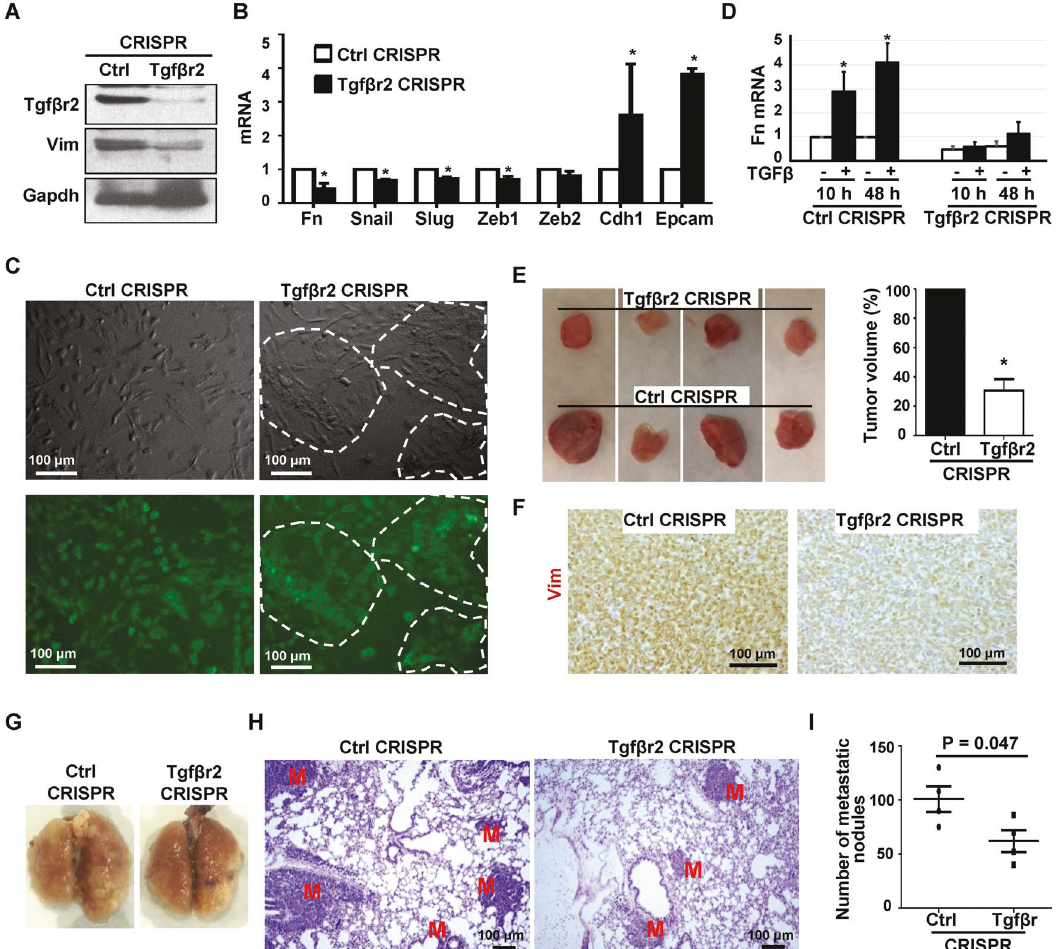
Fig. 5 Deletion of Tgf β r2 in Brca1-de fi cient tumor cells inhibits EMT and suppresses tumorigenesis and metastasis. A – C p18 − / − ; Brca1 MGKO tumor cells were transfected with Tgf β r2 (Tgf β r2 CRISPR) and Control (Ctrl CRISPR) Double Nickase plasmids then selected with puromycin for 3 days. Tgf β r2- and control-knockout cells were then analyzed by western blot ( A ), Q-RT-PCR (B), and microscope for cell morphology ( C ). The areas with epithelial-like cells are indicated in ( C ). D Tgf β r2- and Ctrl-knockout p18 − / − ; Brca1 MGKO mammary tumor cells were treated with vehicle or TGF β for different time periods, and the expression of Fn was then determined. Data in ( B ) and ( D ) represent the mean ± SD from duplicates of two independent experiments. The asterisk (*) in ( B ) denotes a statistical signi fi cance from Tgf β r2- and Ctrl-knockout samples, and in ( D ) denotes a statistical signi fi cance from TGF β treated and vehicle treated samples determined by a two-tailed, paired T test. E , F 6 ×10 5 Tgf β r2- and Ctrl-knockout p18 − / − ; Brca1 MGKO mammary tumor cells were inoculated into the left and right inguinal MFPs of NSG mice, respectively, in a pairwise manner. Two weeks after transplantation, mice were dissected. The volume ( E ) and expression of Vim ( F ) of the regenerated tumors were determined by measurement and IHC. Data in ( E ) represent the mean ± SD of four tumors in each group. The asterisks (*) denote a statistical signi fi cance from Tgf β r2- and Ctrl-knockout tumors determined by a two-tailed, paired T test. G – I 6 ×10 5 Tgf β r2- or Ctrl-knockout p18 − / − ; Brca1 MGKO mammary tumor cells were inoculated into the MFPs of NSG mice. When newly generated tumors reached the maximum size allowed by IACUC in 4 – 7 weeks, or the mice became moribund, lungs were examined for gross appearance ( G ), H.E. staining ( H ), and quanti fi cation of the number of metastatic nodules ( I ). M, metastatic nodules. Data in ( I ) represent the mean ± SD for the numbers of metastatic nodules detected in all lobes of the lungs in each group ( n = 4). Statistical signi fi cance was determined by a two-tailed, unpaired T